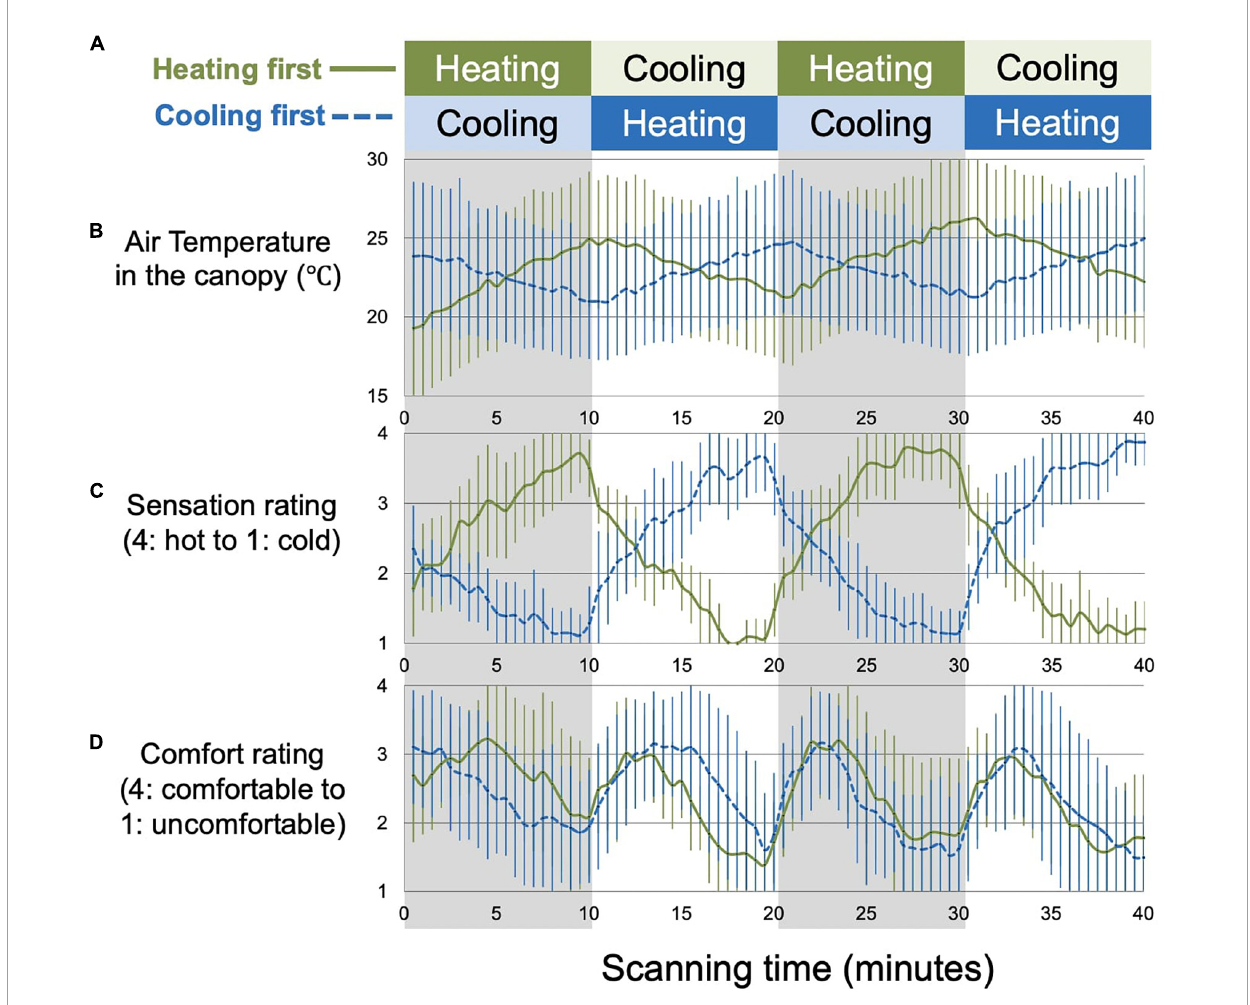
FIGURE1 Thermal manipulation and perceptual measures. Each session consisted of two alternations of 10 min heating and 10 min cooling phases; the session began with the heating phase (heating first) for 14 participants and with the cooling phase (cooling first) for 14 participants (A) . The corresponding average time-series data for the air temperature in the canopy (B) and the two subjective measures [i.e., sensation and comfort/uncomfortable ratings: (C,D) respectively] are shown separately for the heating first (solid line) and cooling first (dashed line) groups. Error bars indicate standard deviations.